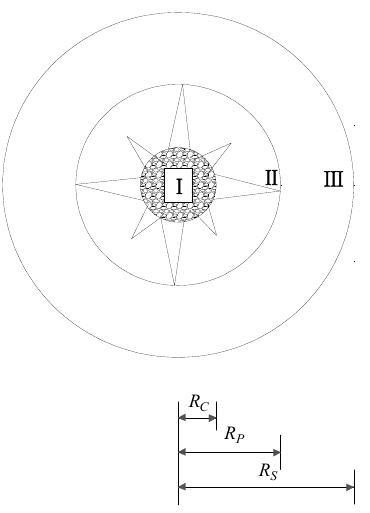
Figure 5. Zone characteristics of shallow-hole blasting.